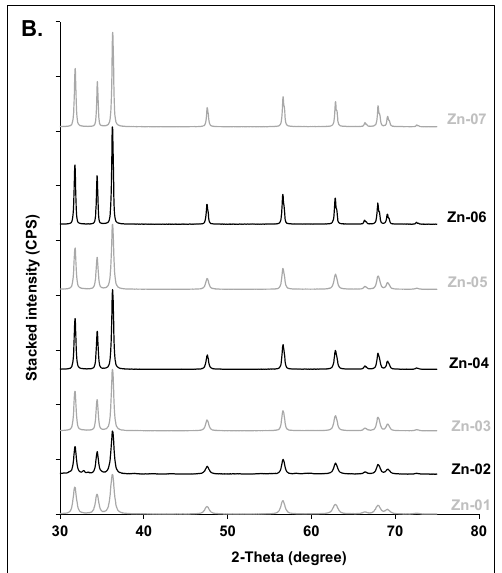
Figure 2. Stacked XRD patterns for ( A ) selected titanium oxides: Ti-02 is representative of 100% rutile ( α -TiO 2 ) while Ti-04 and Ti-06 are 100% anatase ( β -TiO 2 ); in-between are mixed species; Ti-08, -09, -10 exhibited similar XRD patterns to Ti-07 and are not shown. ( B ) zinc oxides; all samples are 100% ZnO. All fitting results are summarized in Table 2.